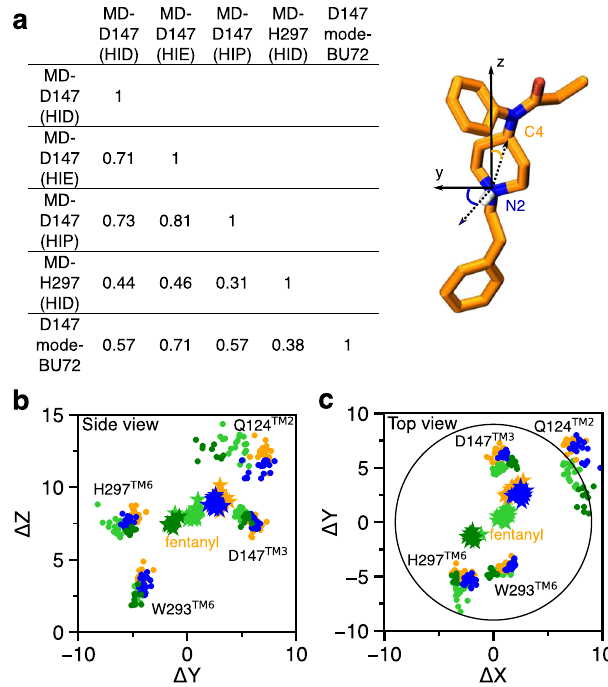
Fig. 5 Contact similarity and spatial relationship between the D147- and H297-binding modes. a Tanimoto coef fi cients ( T c ) calculated using the binary contacts (details see Methods and Protocols). T c ranges from 0 to 1, where 1 indicates identical mOR residues are involved in fentanyl binding in both simulations. b , c Locations of fentanyl (stars) and critical amino acids (circles) plotted on the ( Y , Z ) and ( X , Y ) planes. Data points are sampled every 10 ns. The center of mass of mOR is set to origin. The data from MD- D147(HID), MD-D147(HIE), and MD-D147(HIP) are colored light green, orange, and blue, respectively, while the data from MD-H297(HID) are colored dark green. The z -axis is the membrane